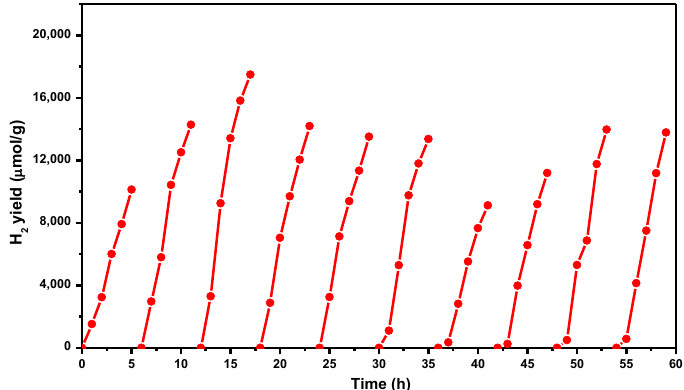
Figure 8. Time courses of H 2 production over Pt/THPP-Pd-TiO 2 and Pt/THPP-Pd/TiO 2 under λ > 420 nm light irradiation.